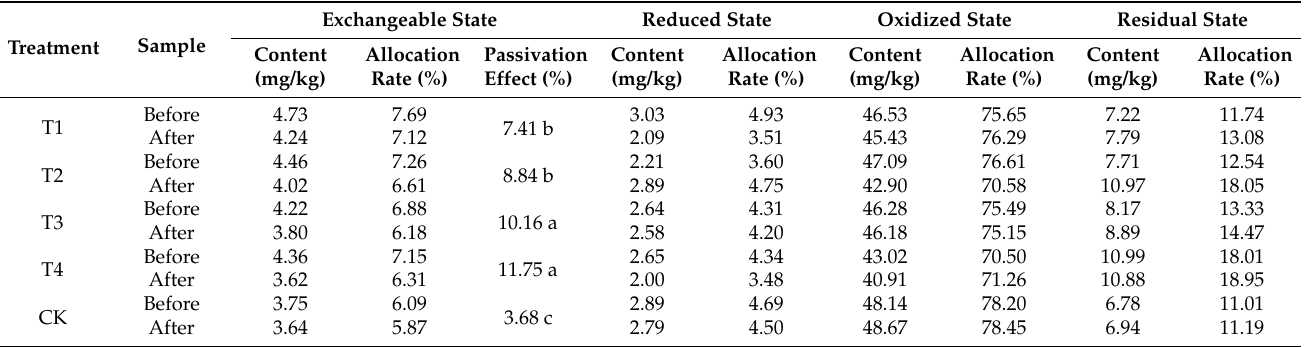
Table 3. Effect of biochar application on speciation of Cu during biogas residue